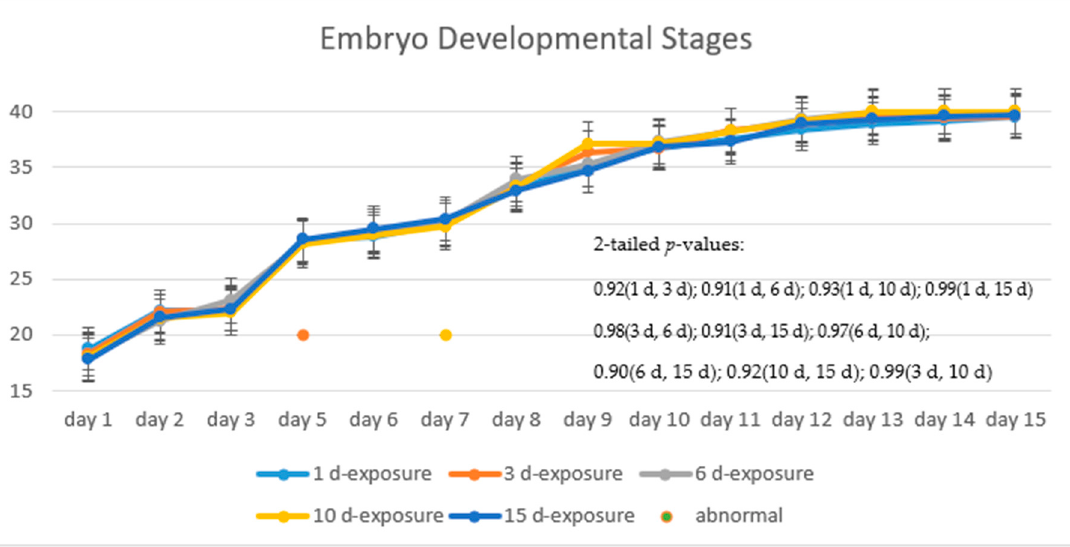
Figure 9. Stages of embryo development of the treated groups with different days of exposure. SMF exposure did not affect the progress of embryo development.